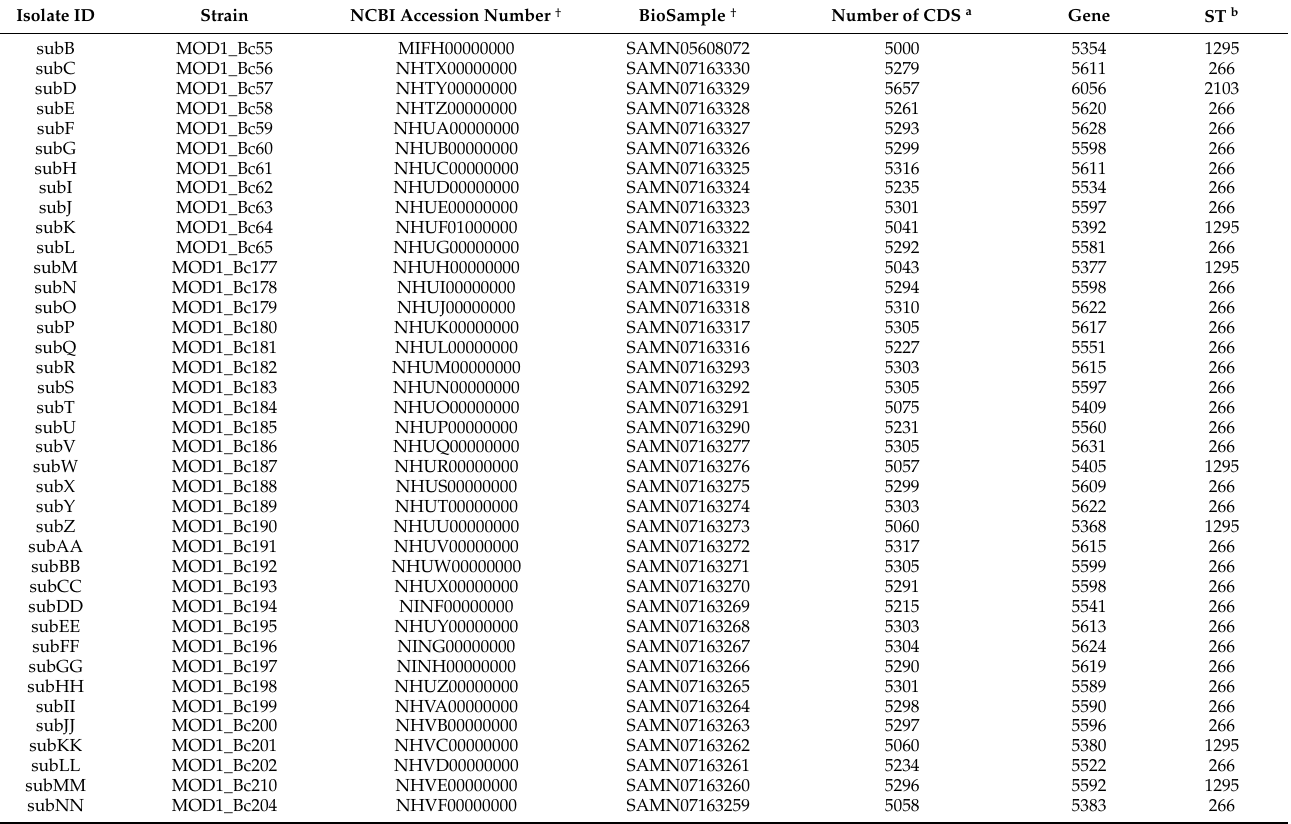
Table 3. WGS assembly, genomic information, and GenBank accession numbers of B. cereus isolates used in this